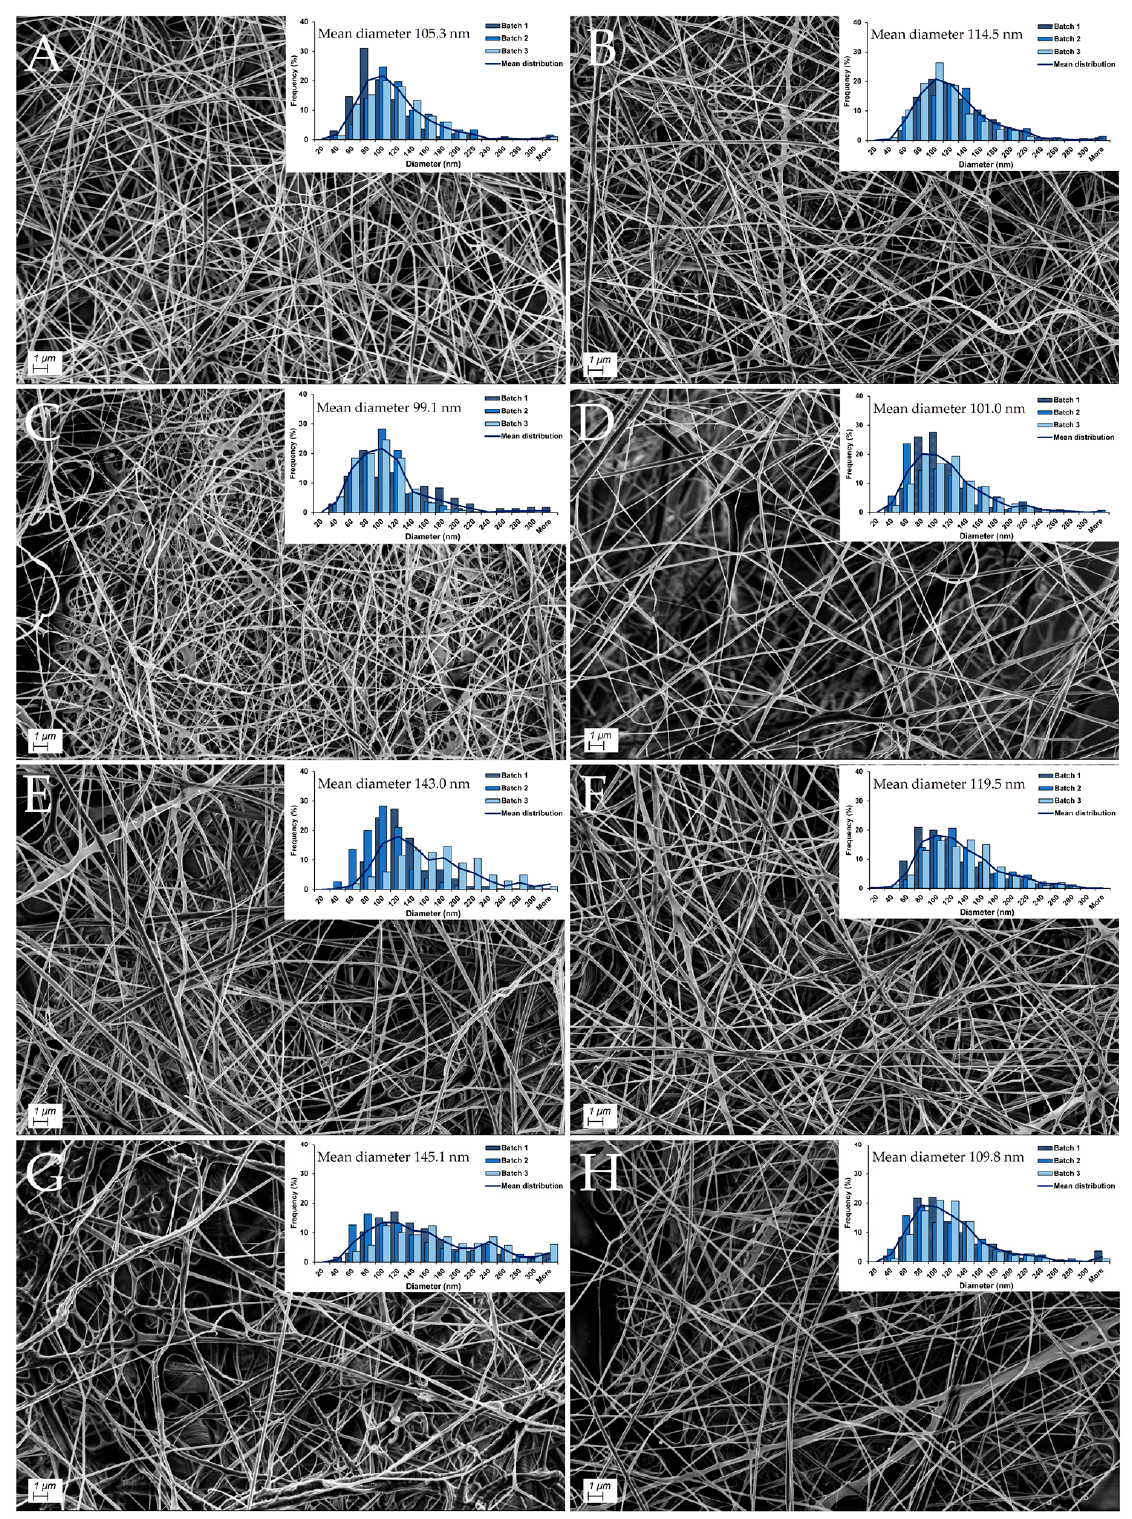
Figure 1. Representative SEM images for each nanofiber formulation. Fiber diameter distribution was determined by measurement of 300 single-fiber diameters for each batch. The overall mean diameter can be found above the diameter distribution ( n = 3). ( A ): β G-CHI-nf, ( B ): β G-CHI-CAM-nf, ( C ): β G-nf, ( D ): β G-CAM-nf, ( E ): CHI-nf, ( F ): CHI-CAM-nf, ( G ): Copol-nf, ( H ): Copol-CAM-nf. Abbreviations: β G ( β -glucan), CHI (chitosan), Copol (co-polymers: polyethylene oxide and hydroxypropylmethylcellulose), CAM (chloramphenicol), nf